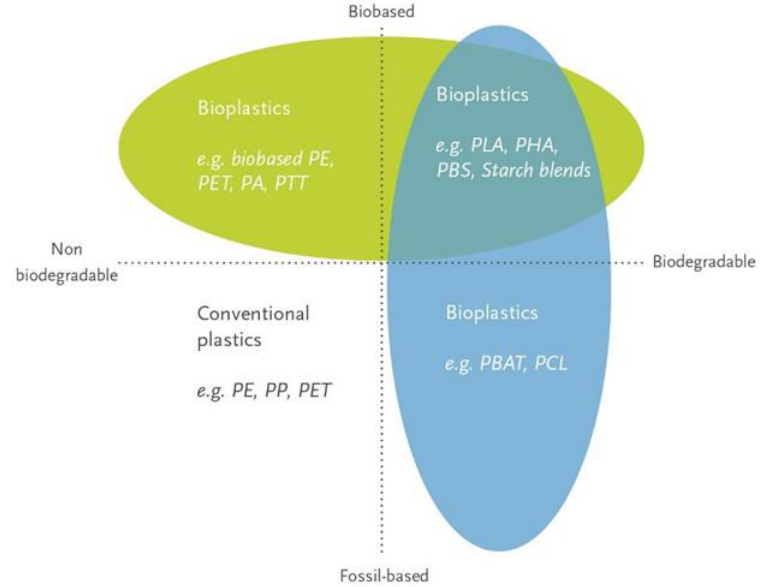
Figure 1. Material coordinate system of bioplastics [8] .